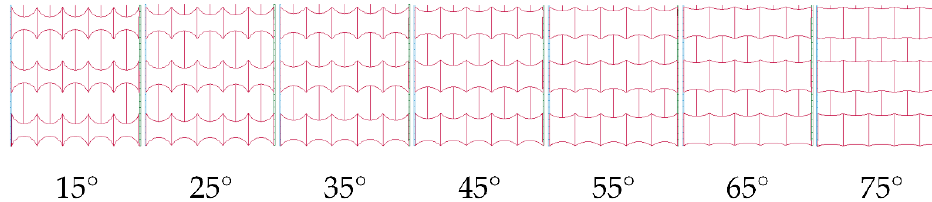
Figure 14. Concave arc honeycomb with different concave angles.